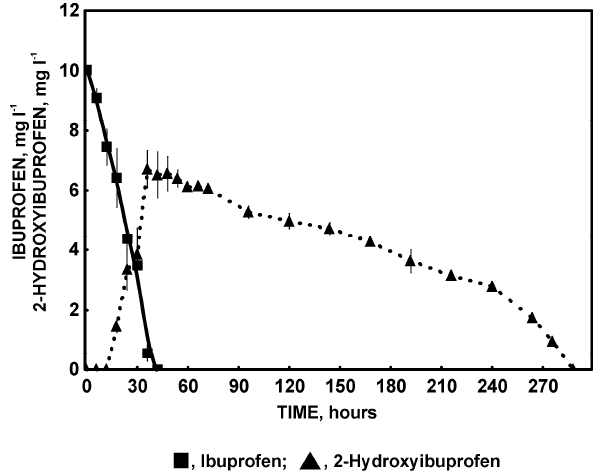
Figure 7. Appearance of 2-hydroxyibuprofen during ibuprofen degradation by Bacillus thuringiensis B1(2015b).